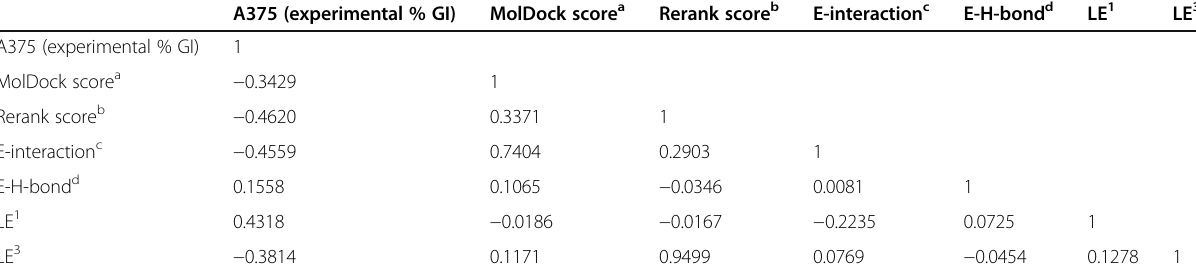
Table 4 Correlation analysis between the experimental % GI and their molecular docking studies on A375 melanoma cell line